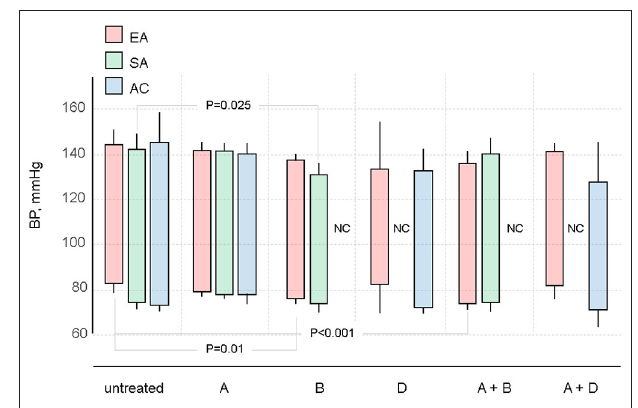
FIGURE 3 | Potential outcome estimates for systolic and diastolic BP in different ethnic groups by antihypertensive treatment regimen. Abbreviations as in Table 3